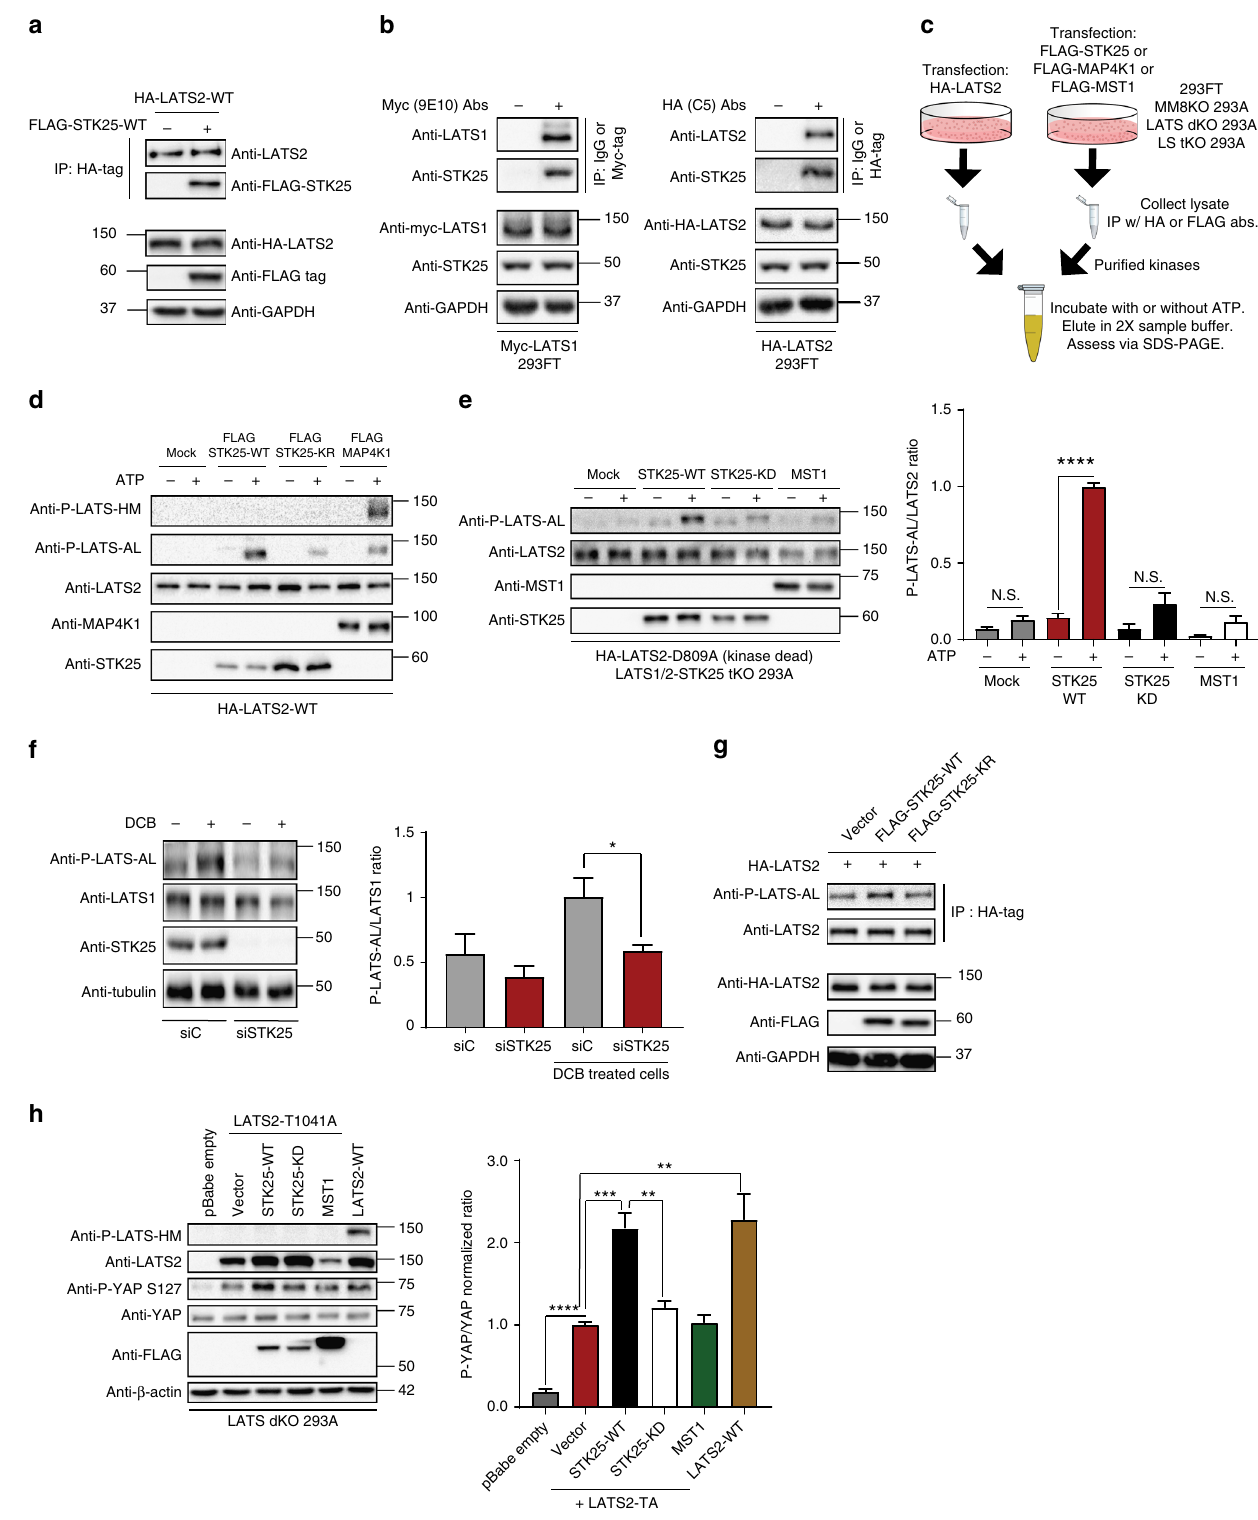
induced YAP phosphorylation upon being grown to con fl uence (Fig. 5a, Supplementary Fig. 5a). By contrast, HEK293A depleted of STK25 exhibited reduced levels of YAP phosphorylation (Fig. 5a, Supplementary Fig. 5b). We also observed reduced TAZ phosphorylation and subsequent stabilization of unpho- sphorylated TAZ levels following loss of STK25